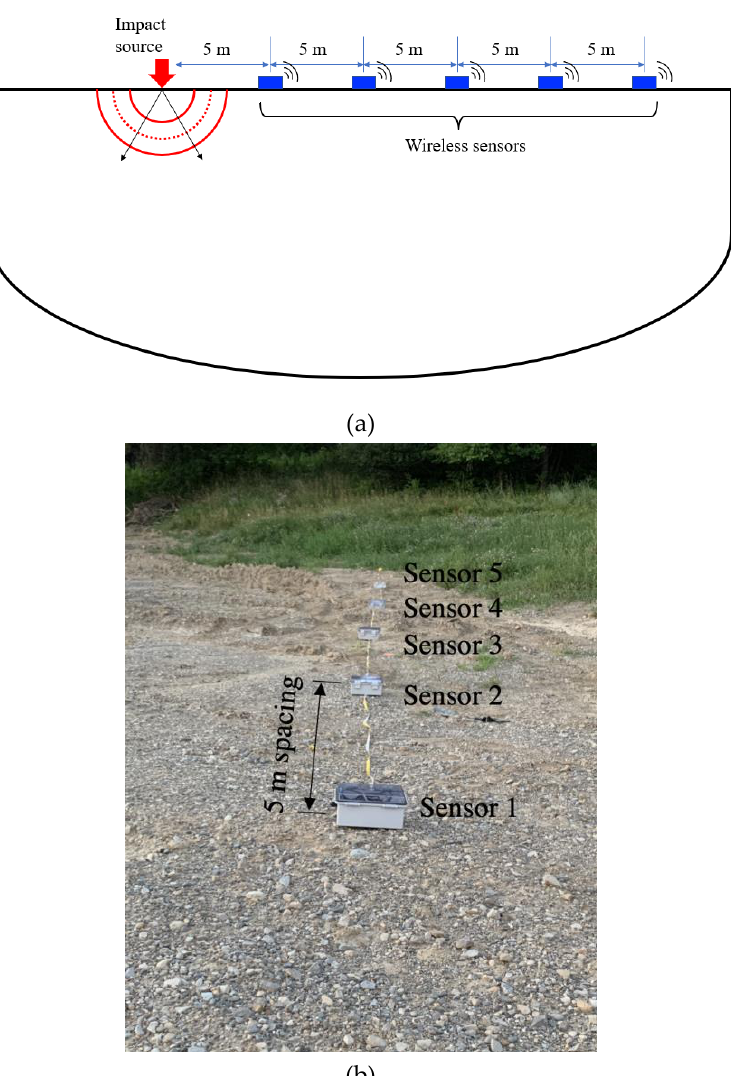
Figure 4. Satellite-based sensing nodes for in-site surface wave testing: ( a ) Schematic of surface wave testing; ( b ) view of testing at the outdoor site.